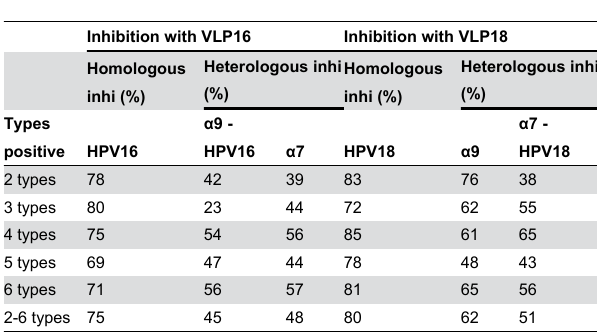
Table 1. VLP16 and 18 homologous inhibition and heterologous inhibition percentages of multi-positive sera induced by HPV